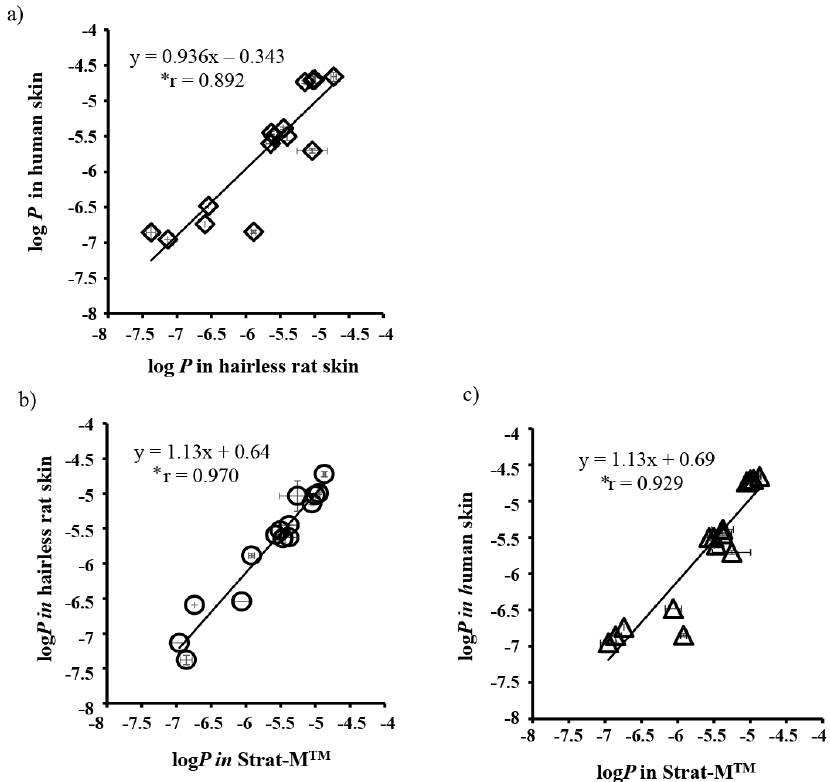
Figure 6. Relationships between log P values of human skin and rat skin or Strat-M ™ . ( a ) Human skin vs. Rat skin, ( b ) Rat skin vs. Strat-M ™ , ( c ) Human skin vs. Strat-M ™ . All results are expressed as the mean ± S.E. (n = 3). Pearson’s correlation coefficient showed significance ( p < 0.05). Reproduced with permission from Uchida et al. [103] .